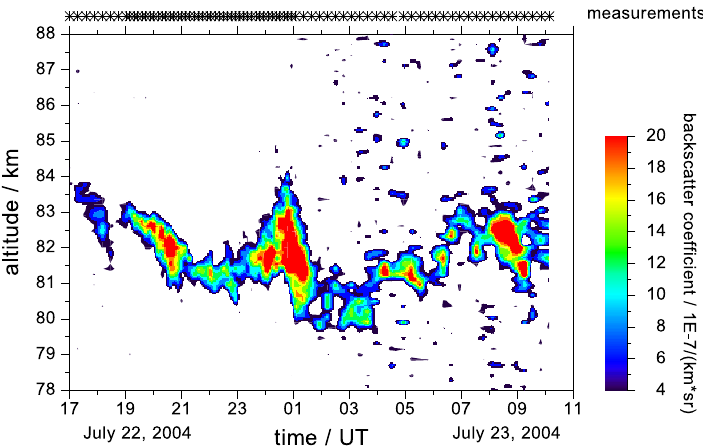
Fig. 7. Lidar observation of a noctilucent cloud on 22/23 July 2004. Shown is the development of the backscatter coefficient β in the parallel polarisation on 532-nm wavelength.